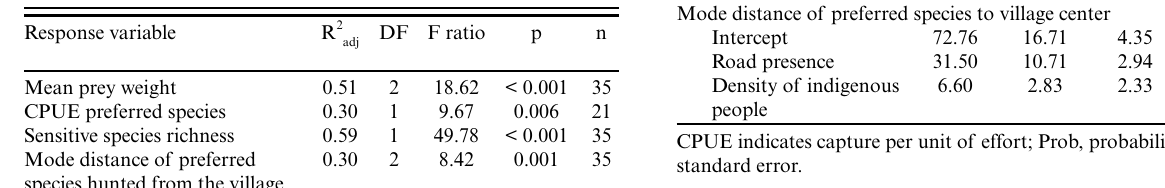
Table 3 . Backward stepwise regression models for all response variables at the village level.